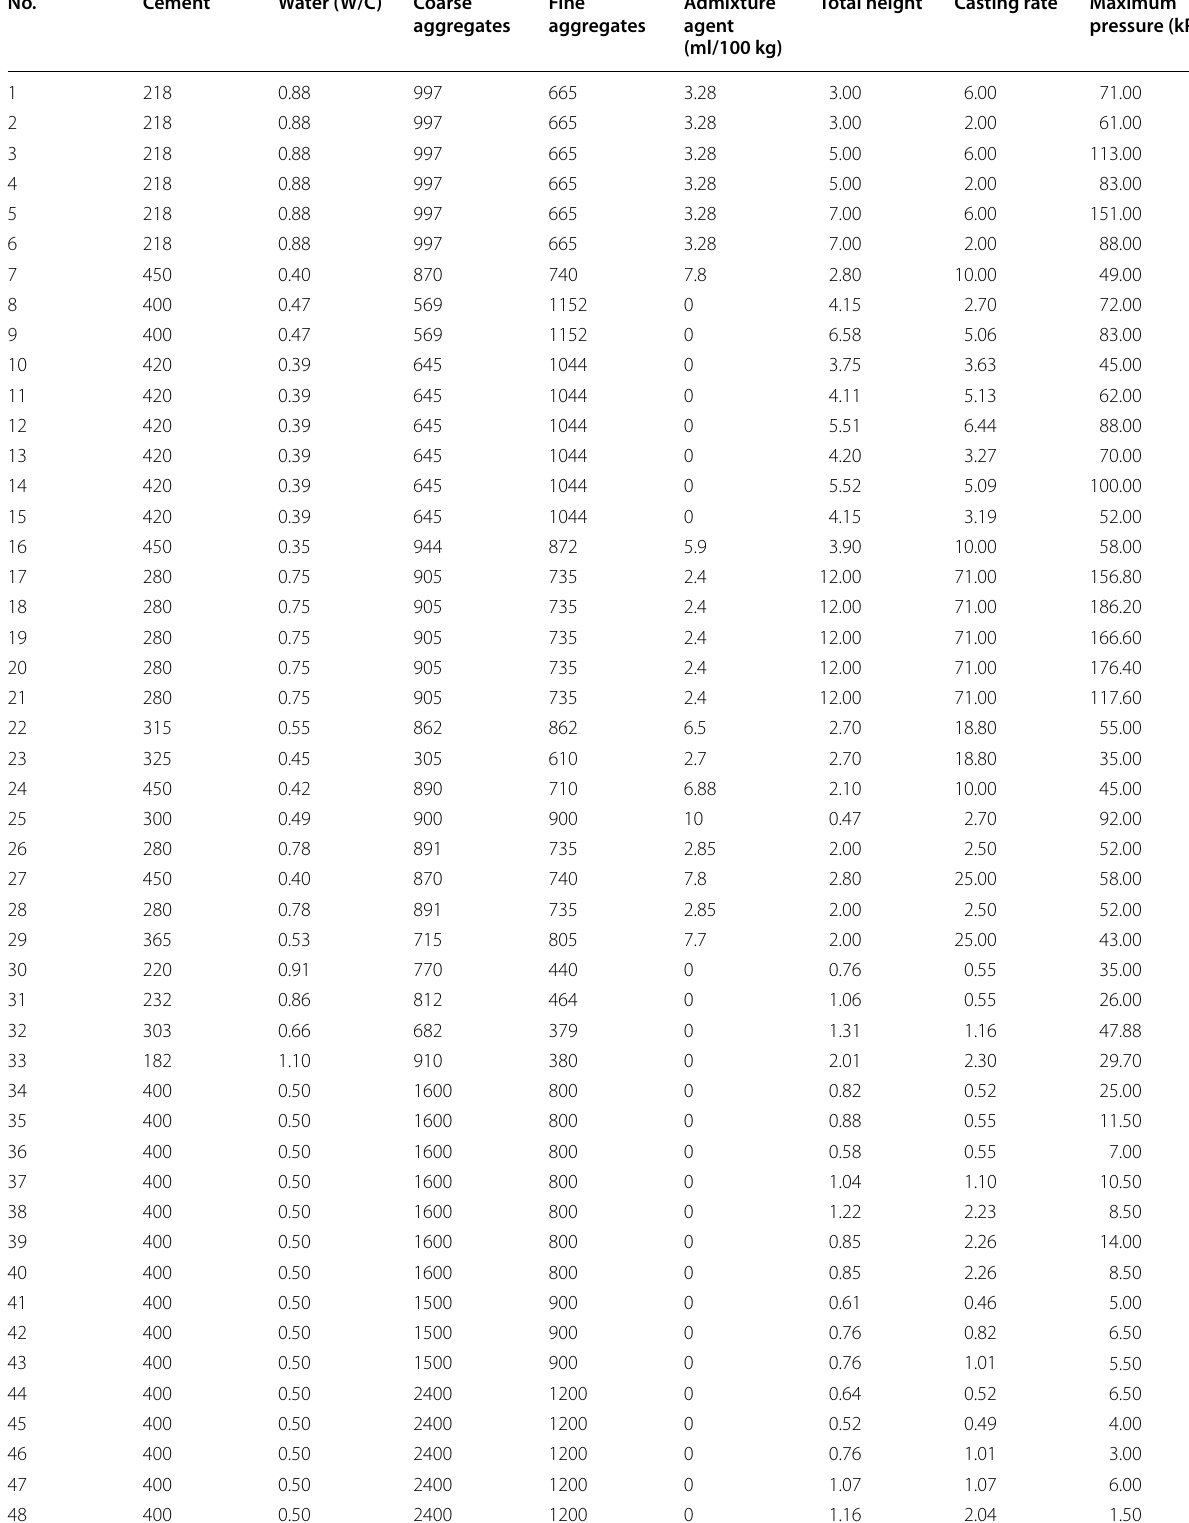
Table 3 A listed result of the research on exerted lateral pressure of concrete on the formwork (Gowripalan et al., 2021).